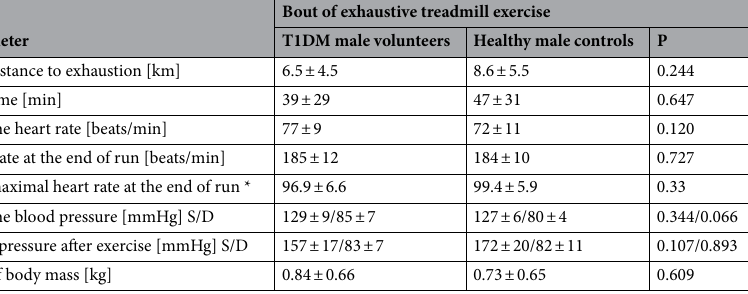
Table 2. Parameters monitored during bouts of exhaustive treadmill run. S systolic, D diastolic, After determination of VO2max at day 1, treadmill exercise test to exhaustion at speed corresponding to 70% of personal VO2max was performed at day 7. Results are expressed as mean ± SD. *Calculated according to Fox formula.